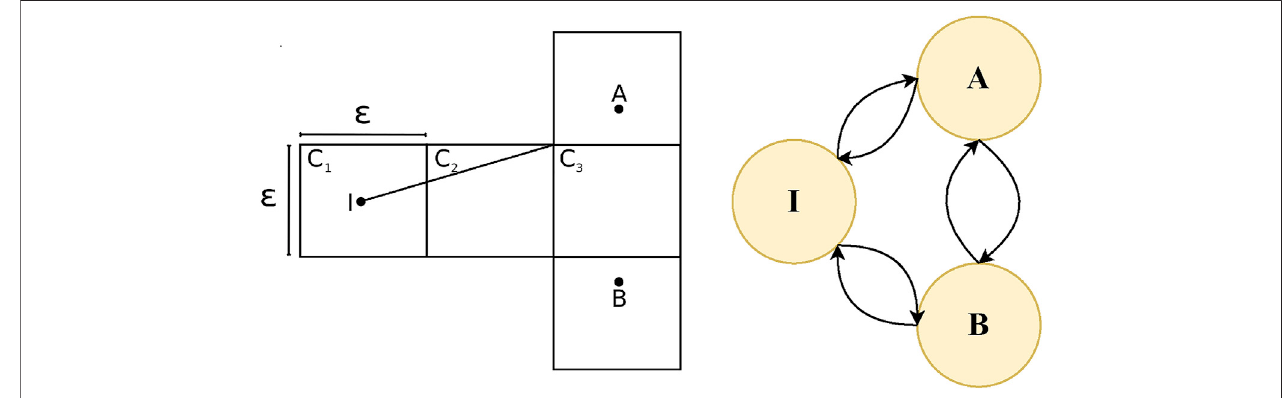
FIGURE1|(Left) DiscretizedgoalrecognitionproblemreplicatedwithpermissionfromKaminkaetal.(2018). (Right) Samegoalrecognitionproblemextendedas a Finite State Machine